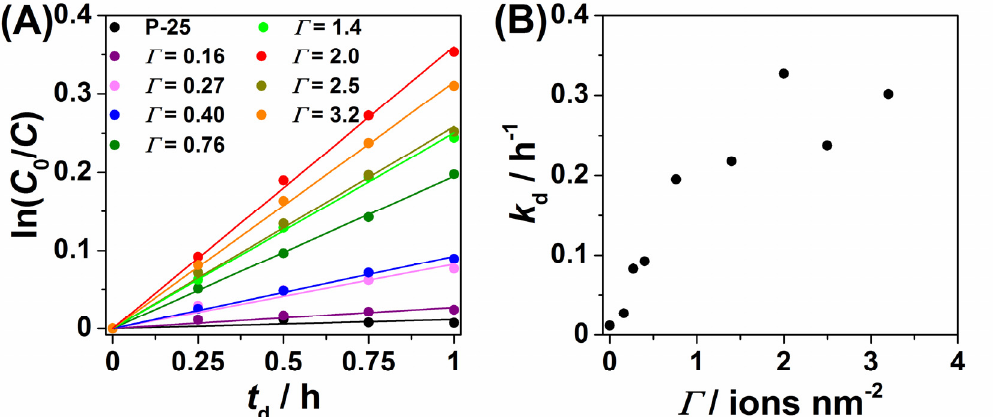
/ C ) versus reaction time ( t ) for the 2-naphthol degradation at 0 d and C denote the 2-naphthol concentrations at t = 0 and t = t , 0 d d ) versus Mn-loading amount ( Γ / ions nm − 2 ). d